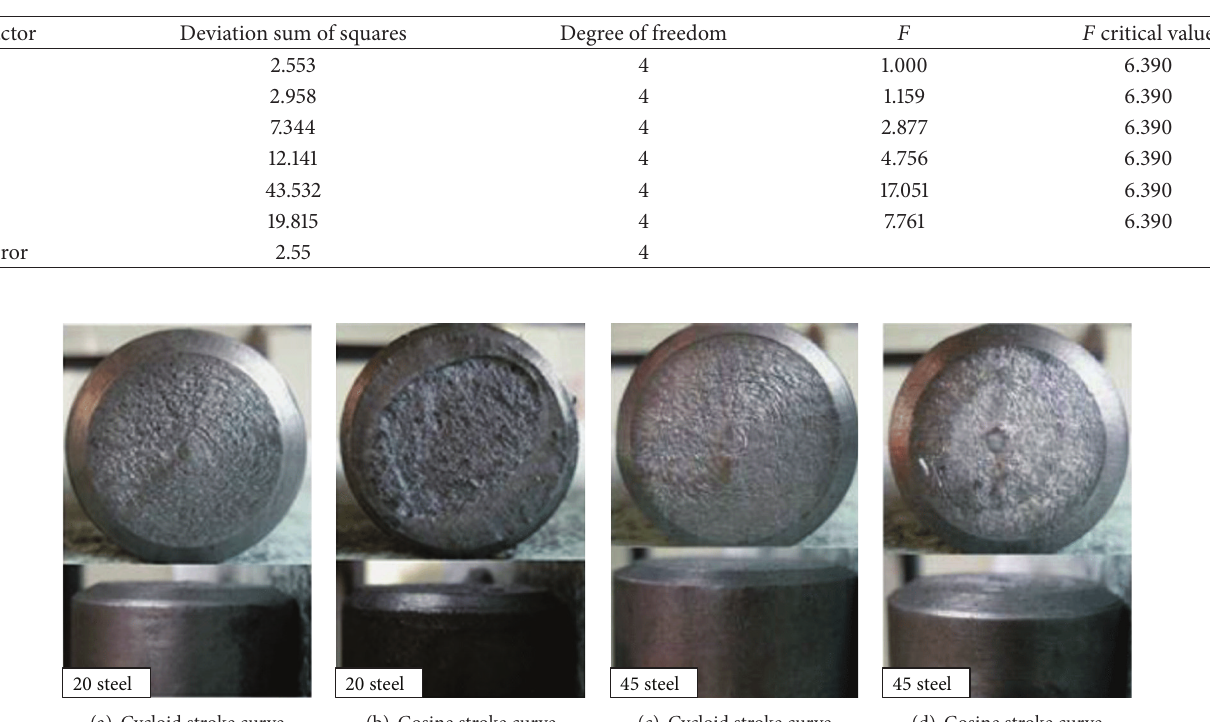
Table 2: The results of analysis of variance.